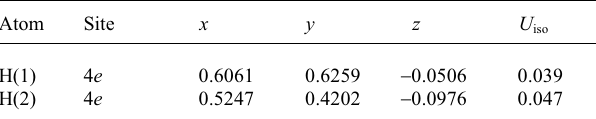
Table 2. Atomic coordinates and displacement parameters (in Å 2 ) .